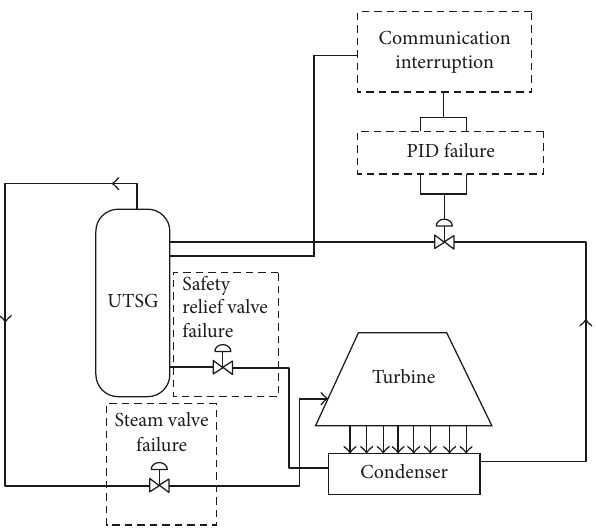
Figure 1: Sketch of the failures that can be injected into the system.